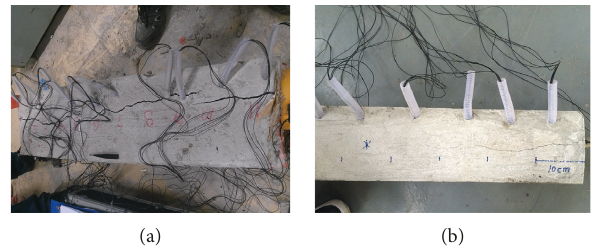
Figure 5: Pullout tests under unconstrained conditions: (a) failure mode under single loading; (b) failure mode under cyclic loading.